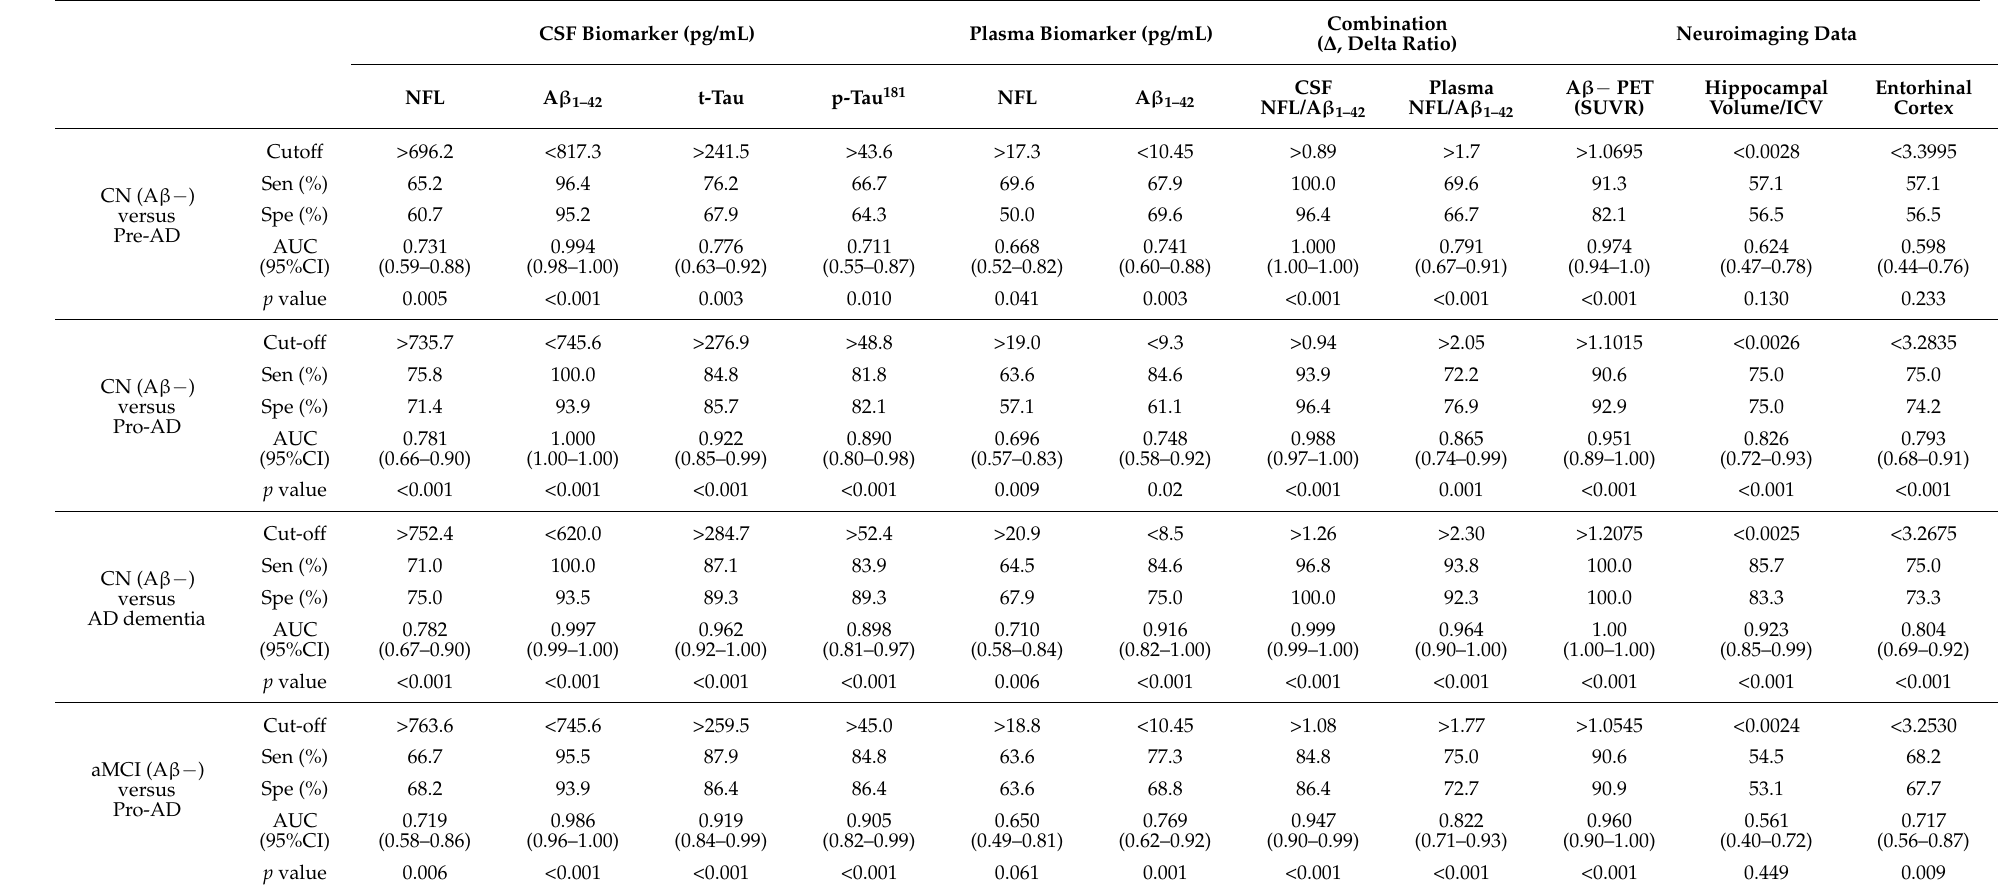
Table 3. Diagnostic accuracy and cut-off values for differentiating patient